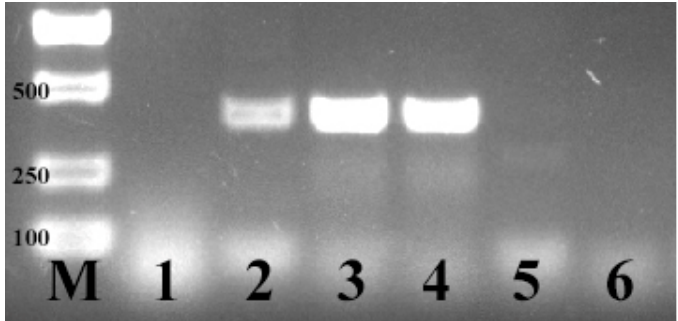
Figure 1. PCR detection of E. coli F17. M: DL 2000 marker; 1: ddH 2 O; 2: E. coli F17; 3,4: lambs’ feces collected during challenge experiment; 5,6: lambs’ feces collected before challenge experiment.